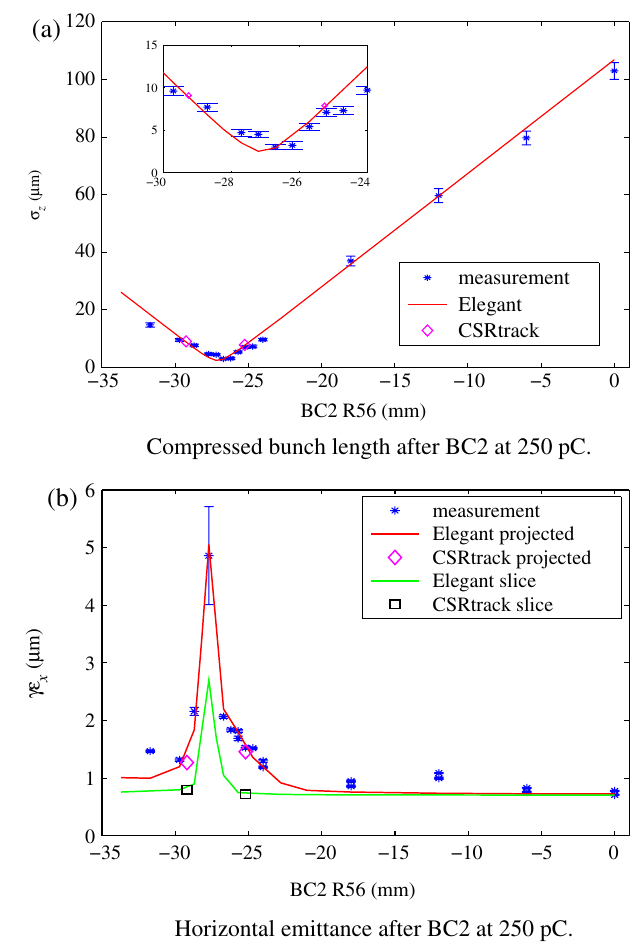
FIG. 8. (Color) BC2 bunch length compression and emittance growth measurements and simulations. (a) Compressed bunch length after BC2 at 250 pC. (b) Horizontal emittance after BC2 at 250